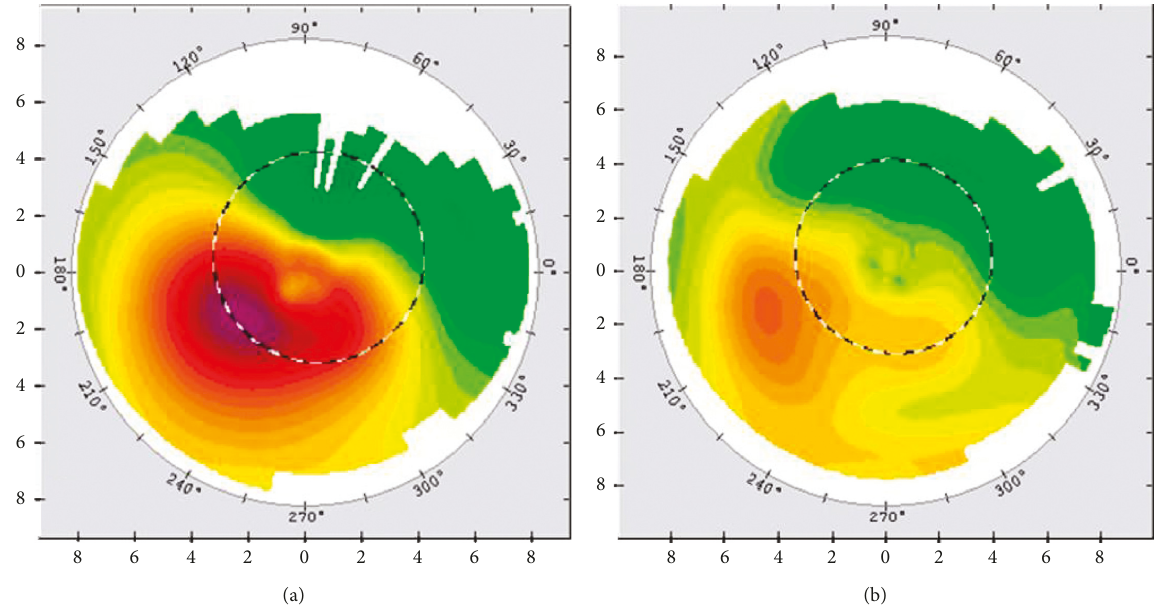
Figure 4: Preoperative and postoperative 24-month follow-up of representative corneal topography. (a) Preoperative corneal topography. (b) Corneal topography follow-up at 24-month after same day PTK, PRK, and CXL treatment in patients with corneal ectasia after LASIK.